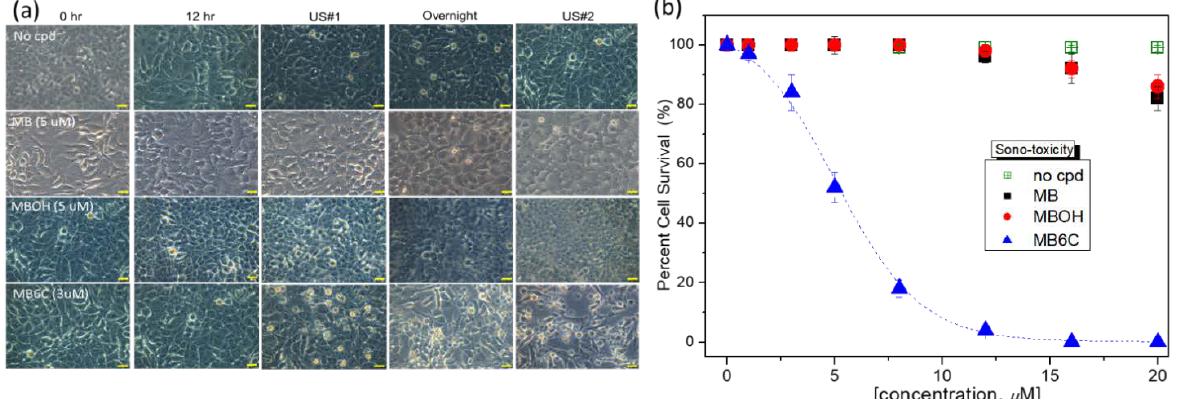
Figure 7. ( a ) Bright-field sonodamage images from A549 lung cancer cells incubated with or without phenothiazine derivatives, 5 µ M MB, MBOH, and MB6C and 3 µ M MB6C, for 12 h and then ultrason- icated for 20 min (conditions are as described in the experimental section, scale bar: 50 µ m). ( b ) Cell sonotoxicity plots of A549 cells treated with variable concentrations of phenothiazine derivatives, as in experiment ( a ) but ultrasonicated twice; each datapoint is the average of three individual